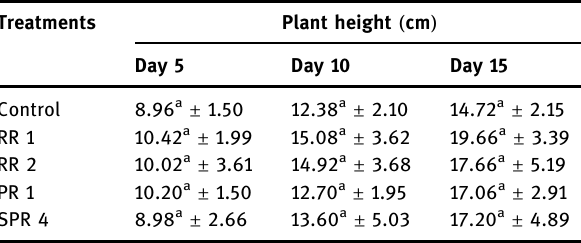
Table 3: E ff ect of PSB on plant height of maize Treatments